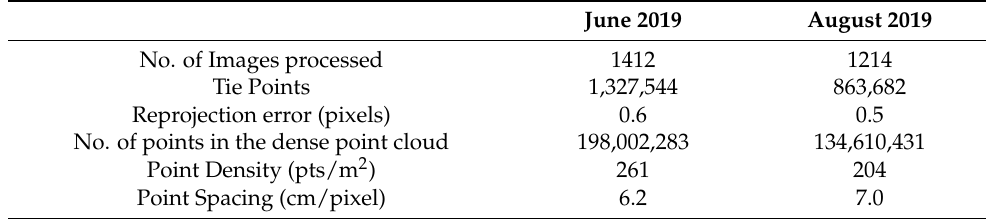
Table 2. Results of SfM processing for each image block (June and August).